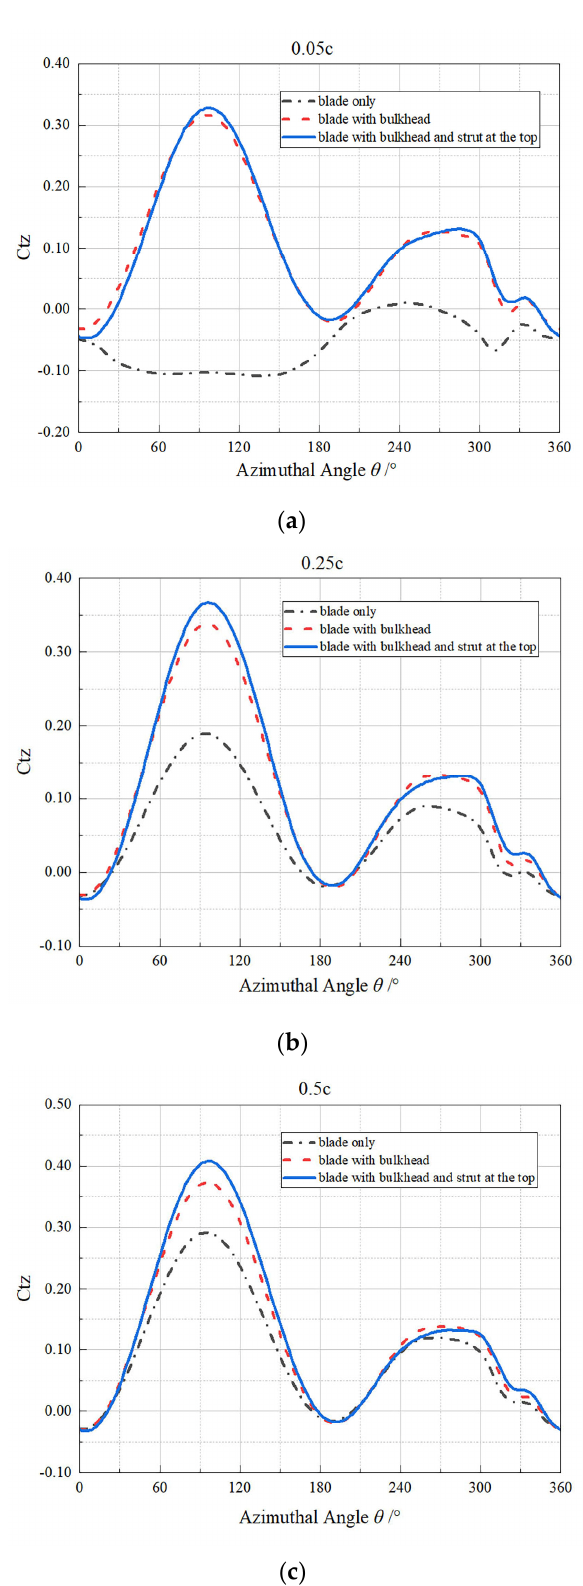
Figure 22. Comparison of instantaneous torque among three different blade tip shapes at height of ( a ) 0.05c; ( b ) 0.25c; ( c ) 0.5c.